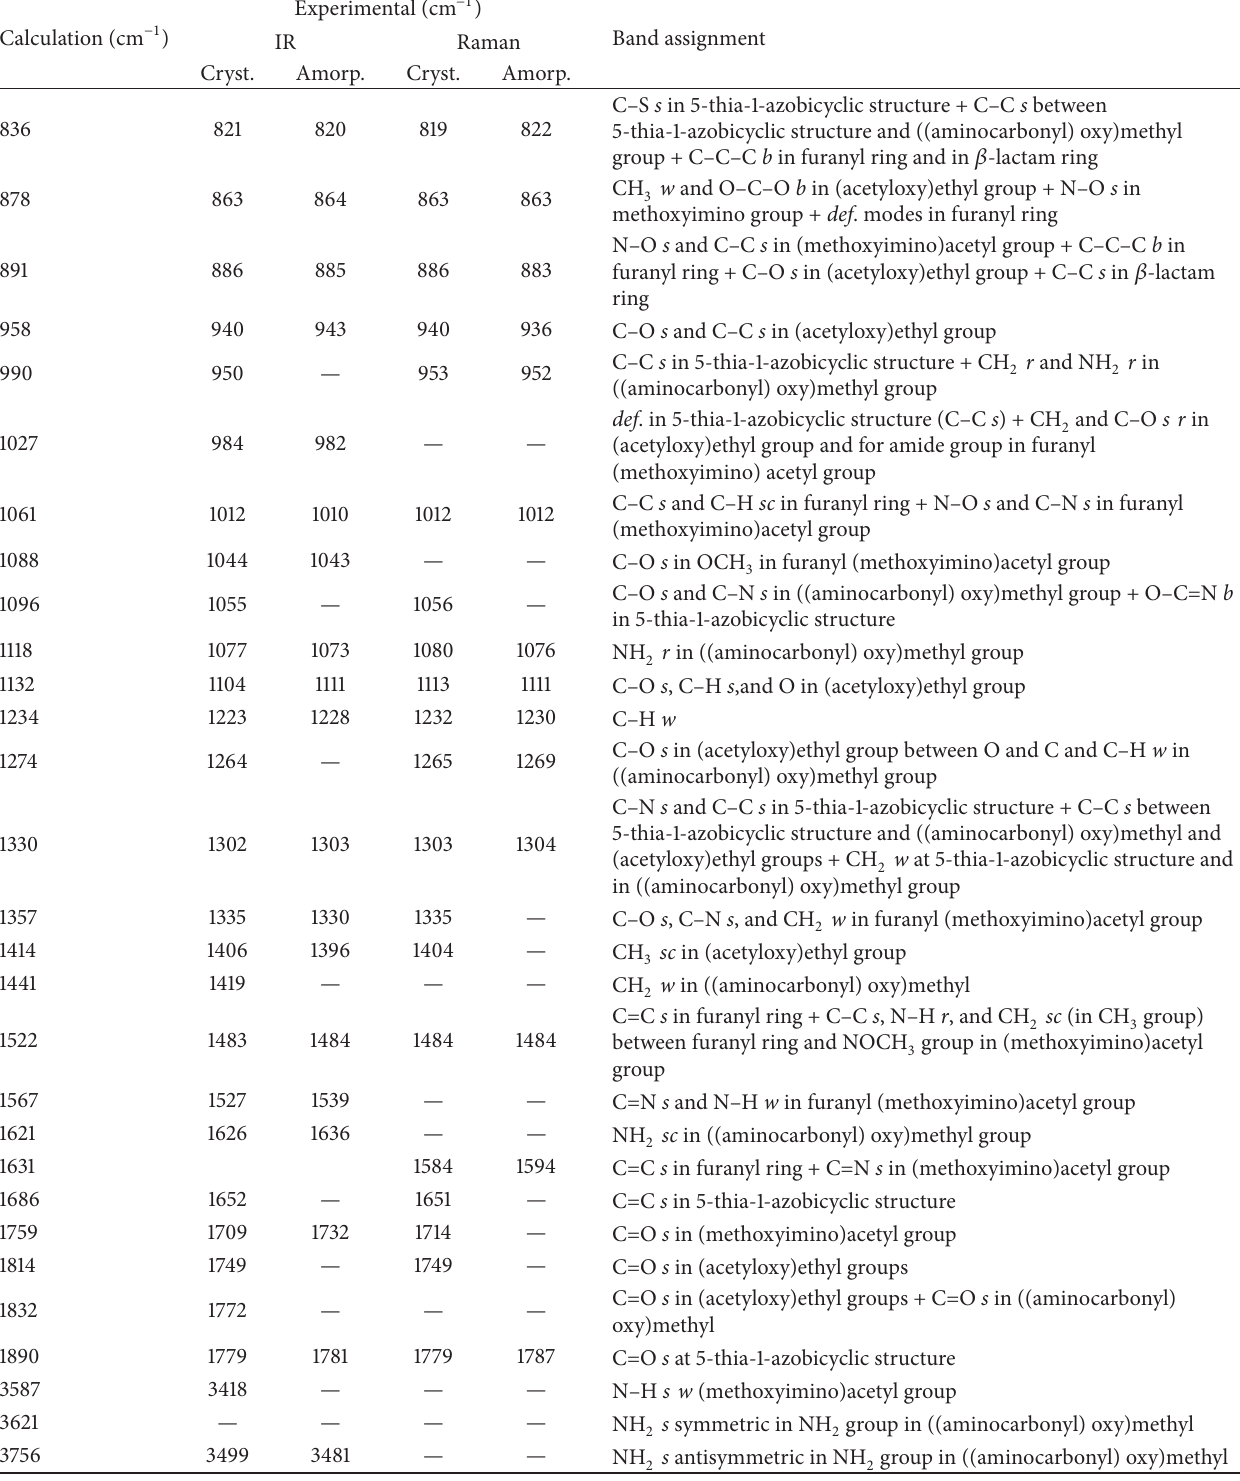
Table 1: Comparison of the observed and calculated vibrational modes of polymorphs of cefuroxime axetil. Calculation (cm −1